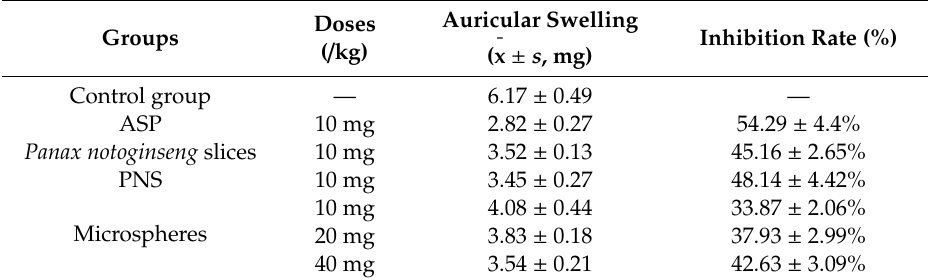
Table 3. Anti-inflammatory activity of PNS microspheres on xylene-induced auricular swelling in